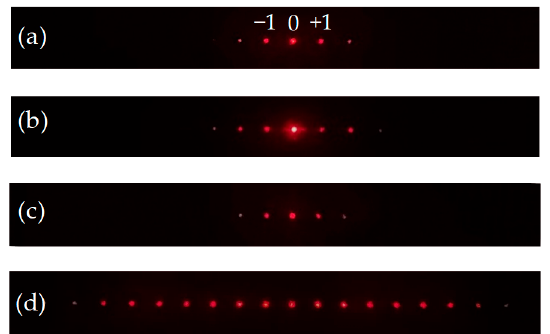
Figure 5. The diffraction patterns of the PDLC grating were probed using a He–Ne laser beam of ( a ) ( a ) the 0 ◦ polarization: IPS without an applied voltage; ( b ) the 0 ◦ polarization: IPS with an applied the 0° polarization: IPS without an applied voltage; ( b ) the 0° polarization: IPS with an applied volt- voltage of 100 V; ( c ) the 90 ◦ polarization: IPS without an applied voltage; and ( d ) the 90 ◦ polarization: age of 100 V; ( c ) the 90° polarization: IPS without an applied voltage; and ( d ) the 90° polarization: IPS with an applied voltage of 100 IPS with an applied voltage of 100 V.